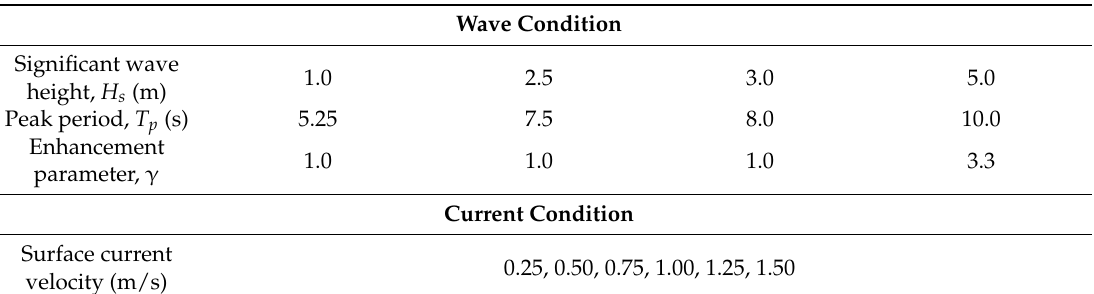
Table 2. Environmental conditions for parametric